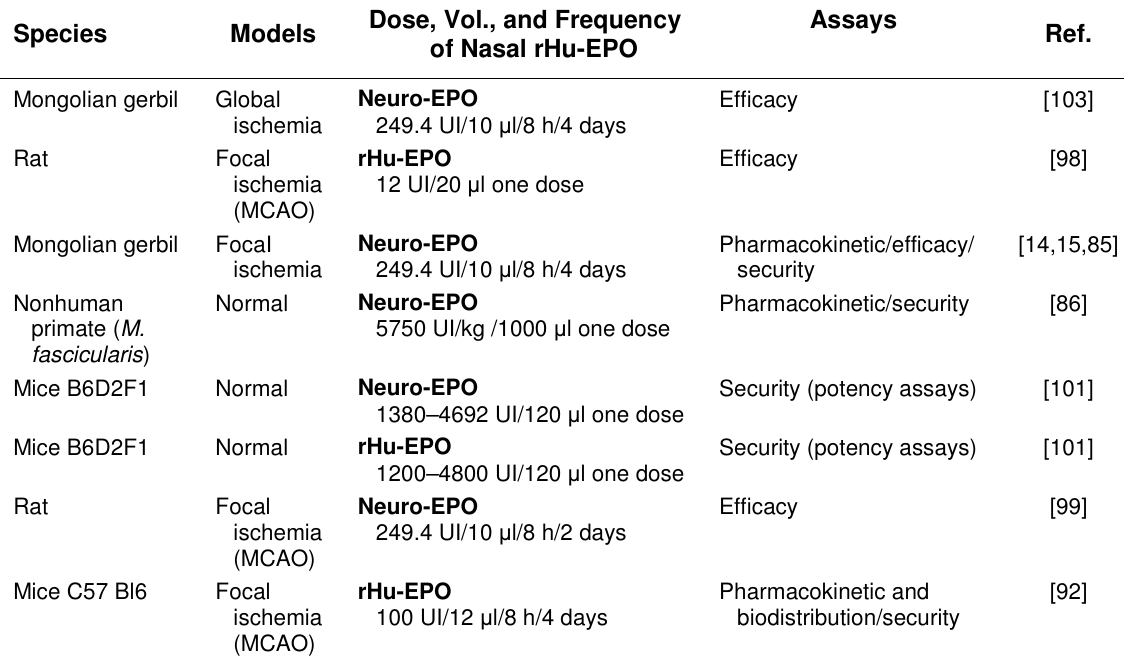
Published Papers of Preclinical Work in Animal Models of Stroke using Intranasal rHu-EPO or Derivatives of rHu-EPO Lacking Erythropoietic Activity Dose, Vol., and Frequency Assays Species Models of Nasal rHu-EPO